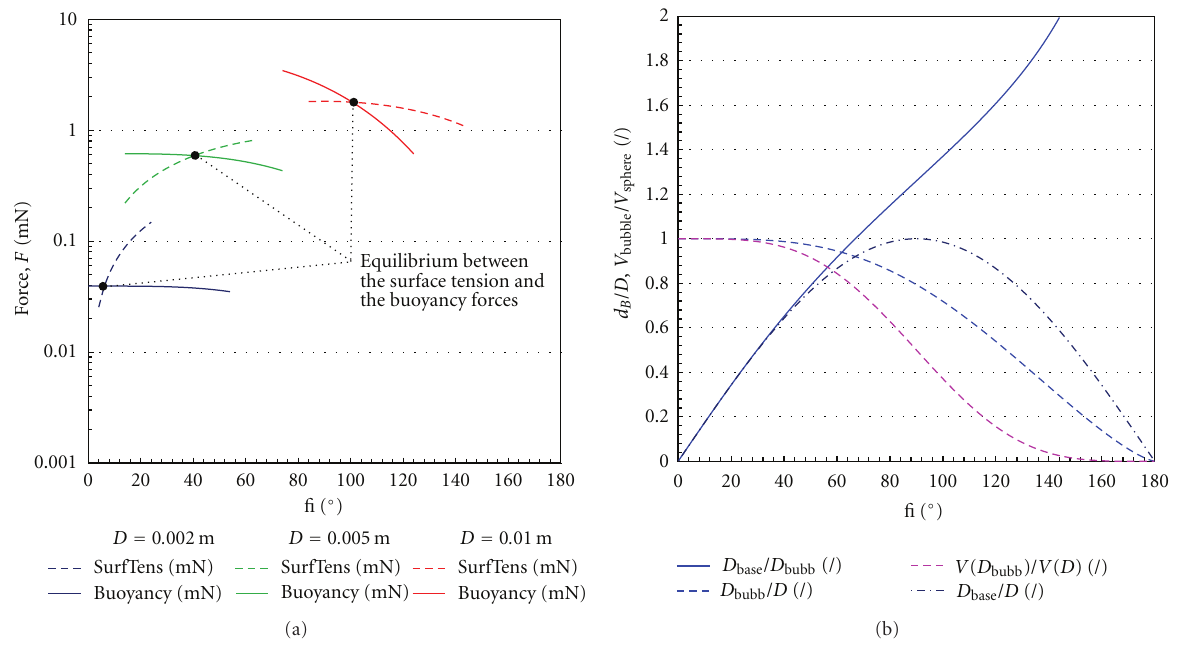
Figure 2: Surface tension and buoyancy force profiles for three di ff erent (virtual) bubble diameters over entire span of contact angles (a), and comparison of characteristic relative quantities